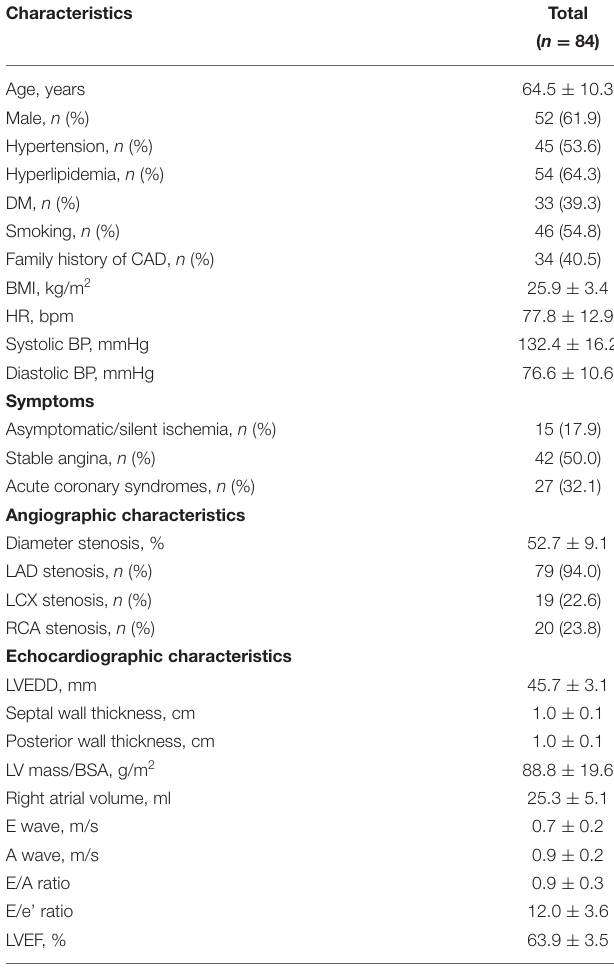
TABLE 1 | General characteristics and angiographic and echocardiographic data in the whole cohort of patients.